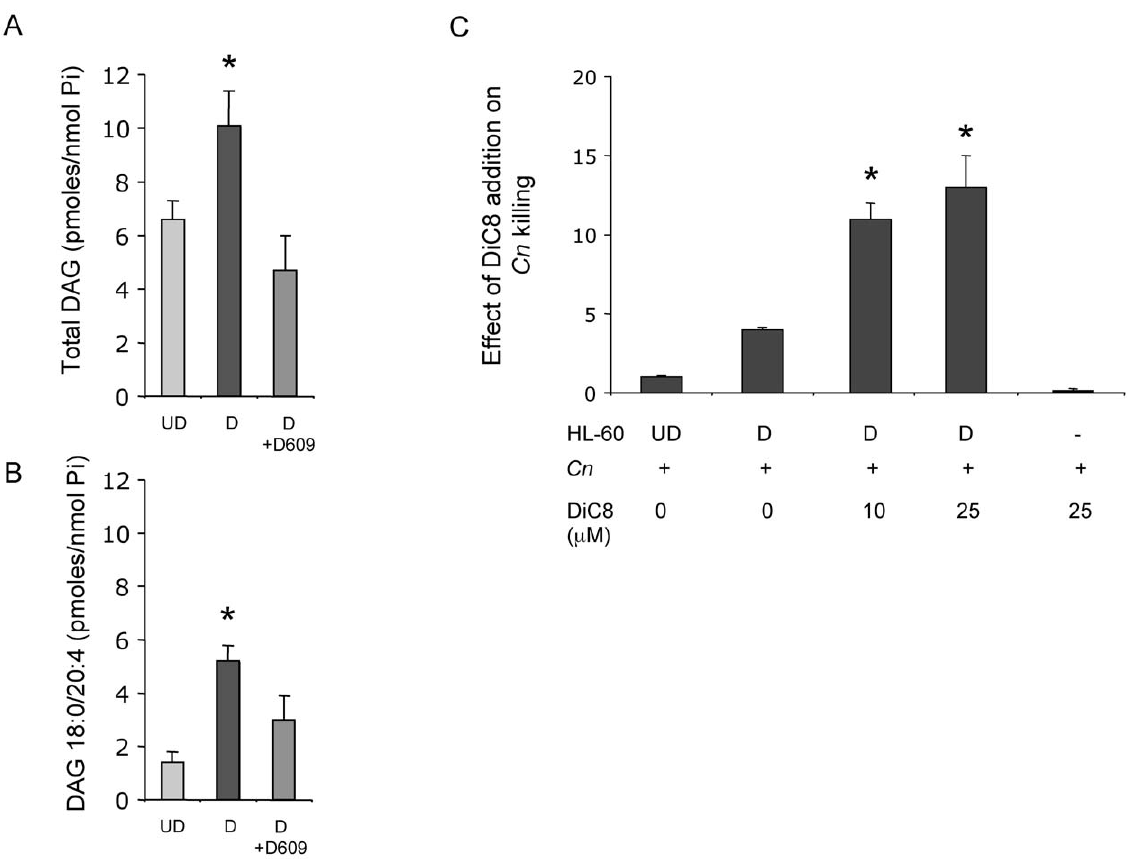
Figure 6. Mass spectrometry analysis of diacylglycerol in HL-60. ( A ) Total levels of DAG in HL-60 undifferentiated (UD), differentiated (D) and HL-60 D treated with D609, as measured by LC-MS and normalized by nanomole of lipid inorganic phosphate (Pi); * P , 0.05, compared to UD cells. ( B ) Specific lipid species for DAG (18:0/20:4) in HL-60 undifferentiated (UD), differentiated (D) and HL-60 D treated with D609, as measured by LC-MS and normalized by Pi. * P , 0.05, compared to UD cells. ( C ) Effect of DiC8 addition on killing activity of differentiated HL-60 cells against C. neoformans ( Cn ) or C. neoformans alone, represented as a fold response relative to HL-60 undifferentiated cells (UD). * P , 0.05, compared to untreated D cells.